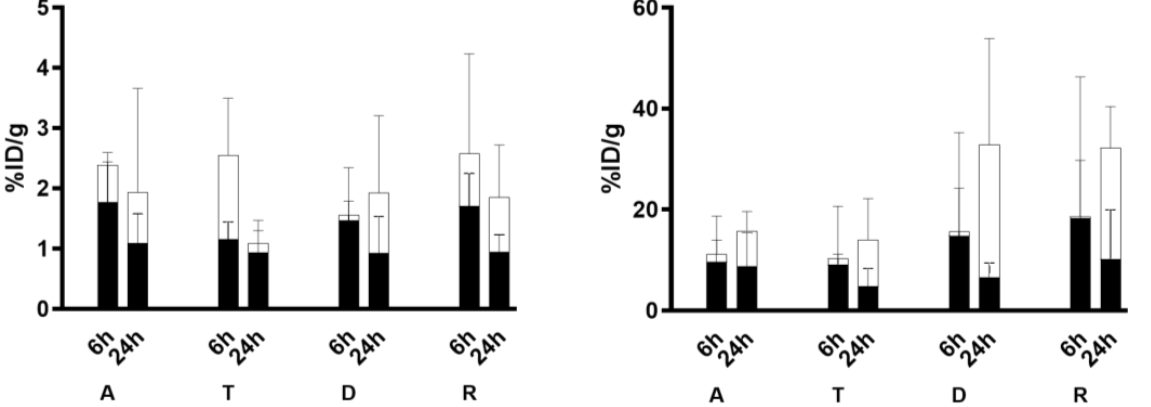
Figure 4. Ex vivo counts of A-T-D-R colon segments of control (black) and DSS (white) mice injected with 99m Tc-anti- α 4 β 7 integrin ( left ) or 99m Tc-anti-TNF α ( right ). Data are expressed as %ID/g ± SD. 99m Tc-anti- α 4 β 7 integrin accumulates particularly in the transvers and descending colon. 99m Tc-anti- TNF α accumulates particularly in the descending colon and rectum at 24 h p.i. A = Ascending colon; T = Transvers colon; D = Descending colon; R = Rectum-sigma.